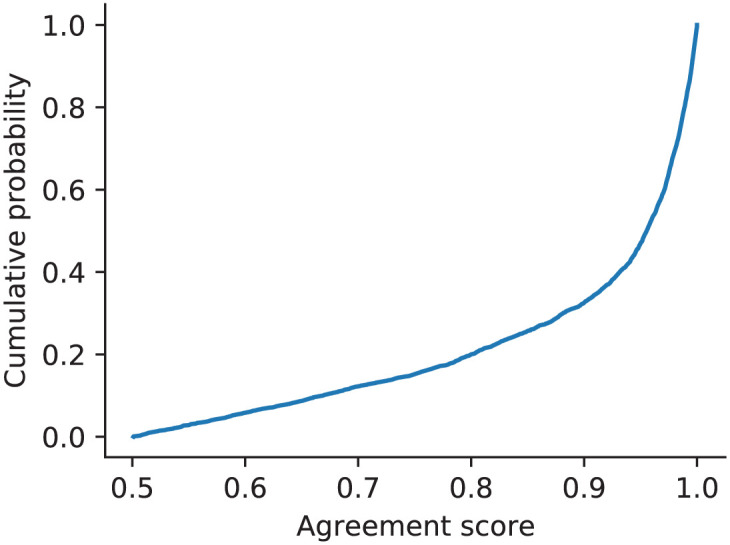
Cumulative histogram of agreement scores (above threshold of .5 that defines a match) for the ensemble sorting of the simulated ground-truth dataset.This analysis was performed with the six chosen sorters and highlights how over 80% of the matched units had an agreement score greater than 0.8.